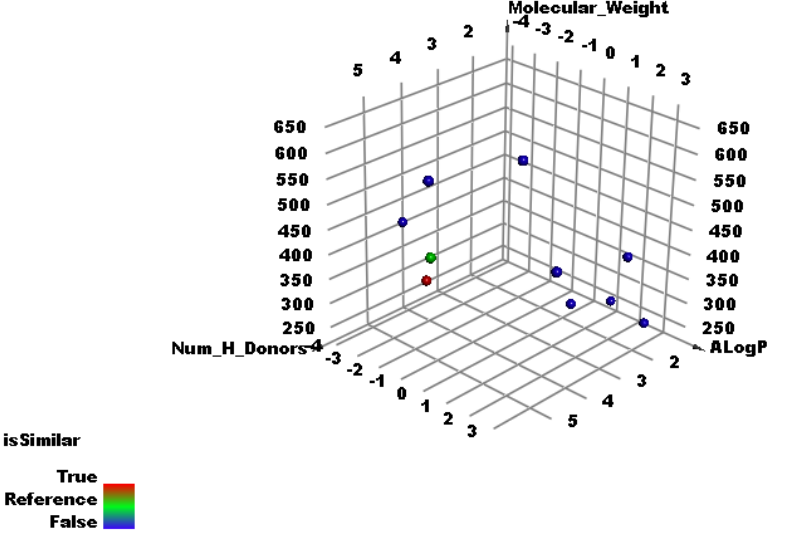
Figure 4. Similarity analysis results: K3G-A (green sphere) appears close to remdesivir (red sphere). Table 2. Structural properties of K3G-A and remdesivir, F86 .